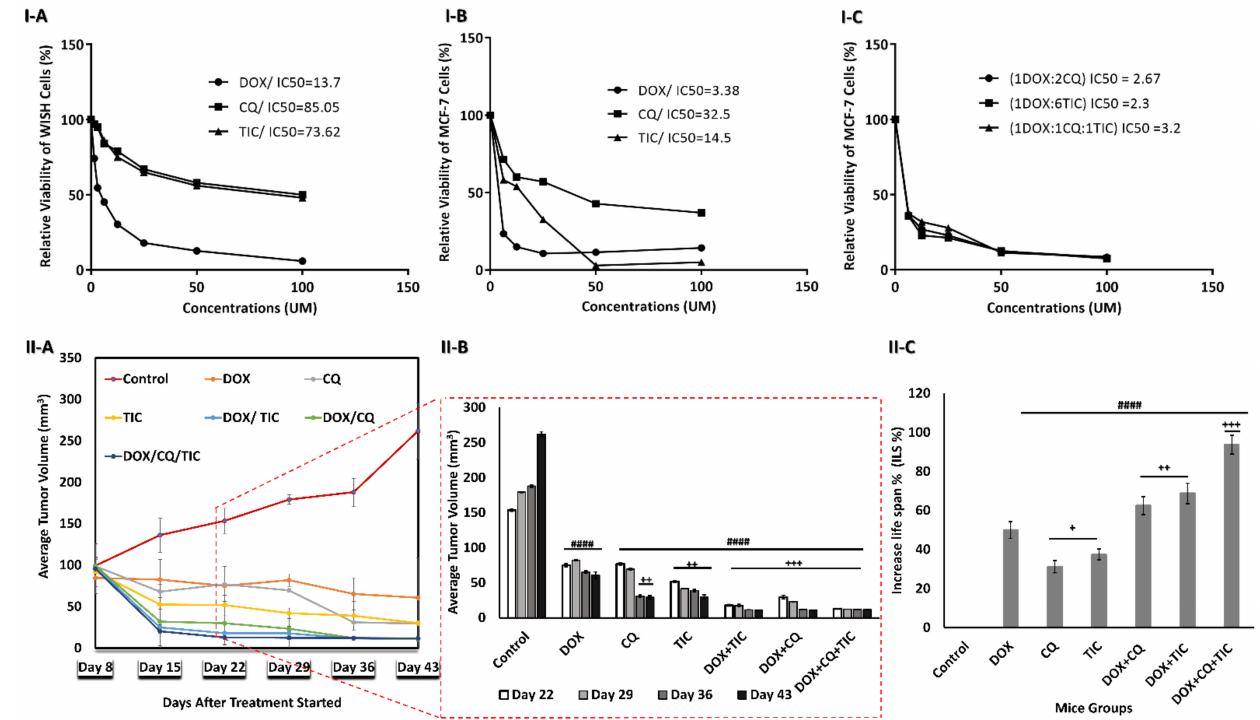
Figure 2. Growth inhibition and aggressiveness of cancer cells assessment. The dose-response inhibition concentration was estimated via MTT assay Plot curve that showing IC50 values of every single DOX, CQ, and TIC treatment on human normal epithelial cells (WISH) cells ( I-A ), MCF-7 cells ( I-B ), and IC50 values of combinatorial therapies ratios of DOX, CQ, and TIC that achieved best combination Index (CI < 1) with a highest toxic effect on MCF-7 breast cancer cells ( I-C ). The cell viability was plotted against drug concentration to calculate IC50 and each data point represents an average of three independent experiments ( n = 3). Growth curve for tumors of MC-7 tumor-bearing xenograft mice, with points representing mean tumor volumes in each group of mice ( II-A ), Bare diagram represent the dramatical difference point change of mean tumor volumes in each group of mice ( II-B ), Average survival time per each group of MCF-7 mice model ( II-C ). Results are expressed as mean ± SE ( n = 3). # p < 0.05, ## p < 0.01, ### p < 0.001, #### p < 0.0001 compared with control (MCF-7-mice untreated group). + p < 0.05, ++ p < 0.01, +++ p < 0.001, ++++ p < 0.0001 compared with the DOX treated mice